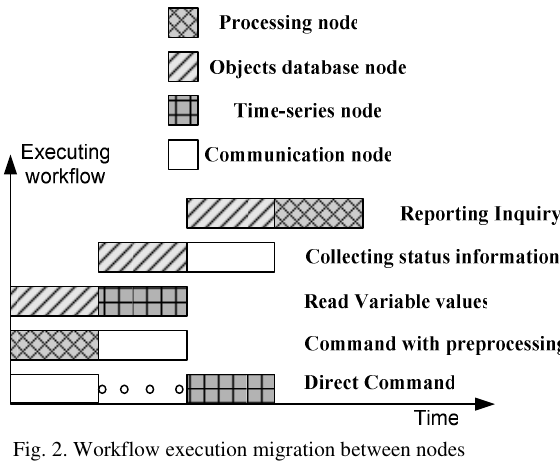
Fig. 2. Workflow execution migration between